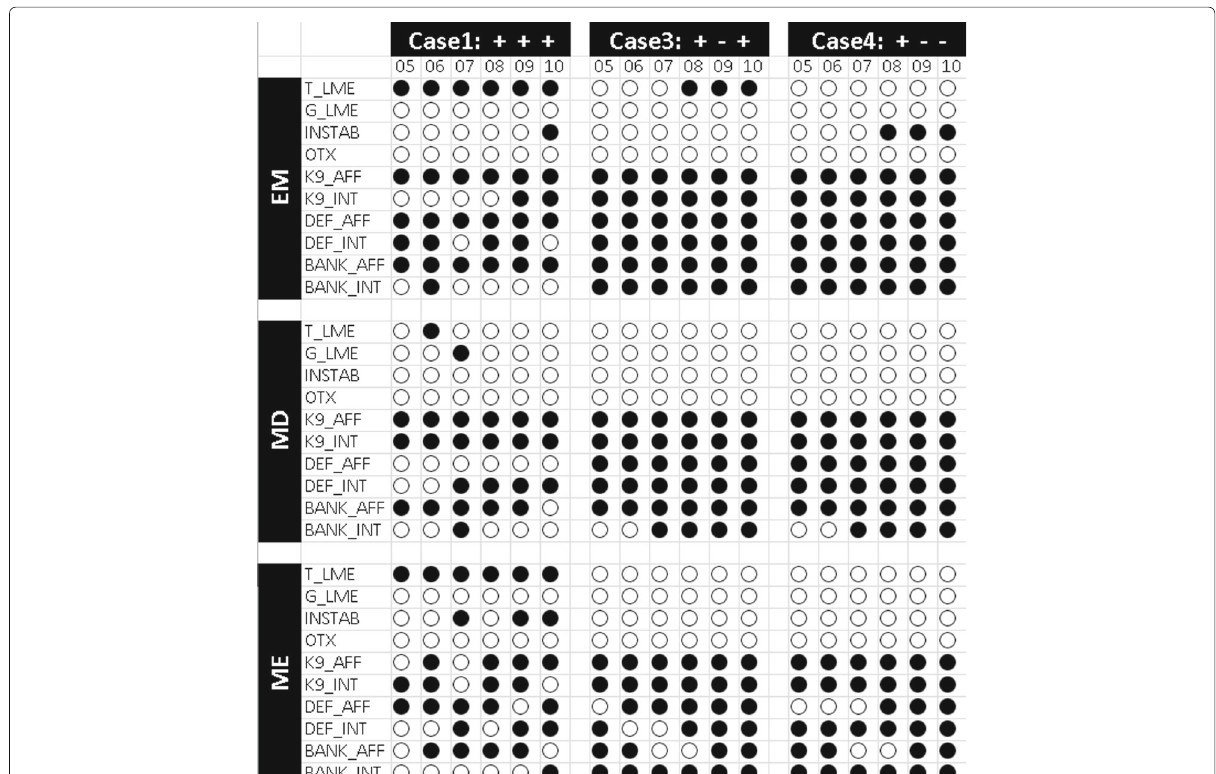
Fig. 8 The importance of signals for EM, MD and ME attack types between May-17 and Oct-17 for cases 1, 3, and